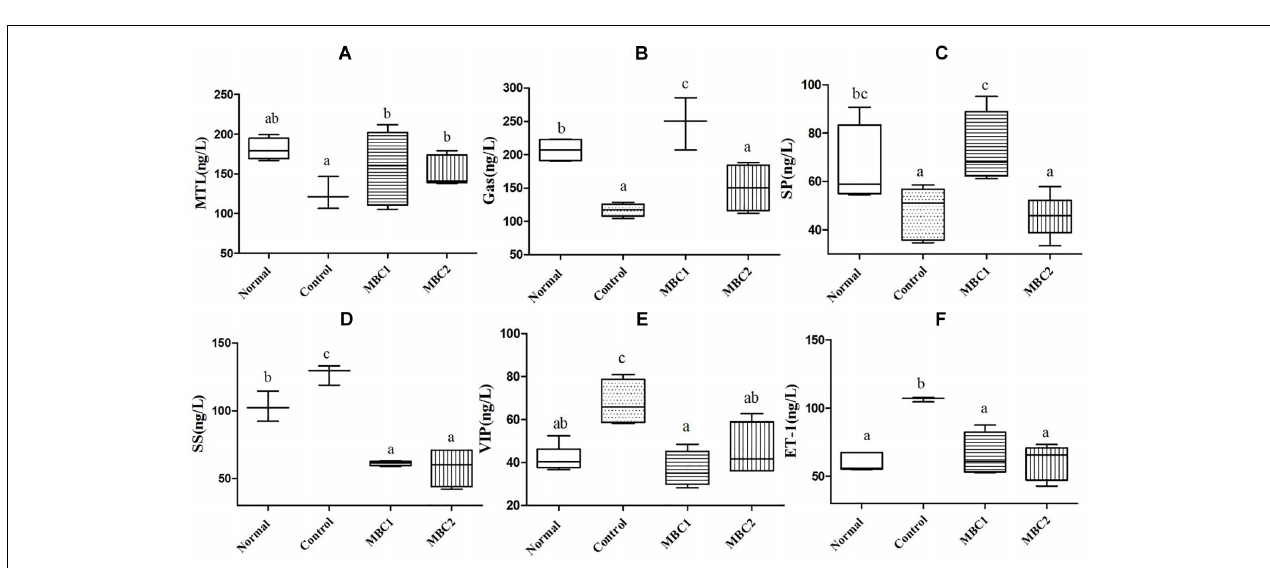
FIGURE 1 | Defecation status of mice during the experiments. (A) Small intestinal transit rate; (B) Time to the first black stool defecation; (C) water content of defecation; a–c, mean values with different letters over the bars are significantly different ( p < 0.05) according to Duncan’s multiple range test.